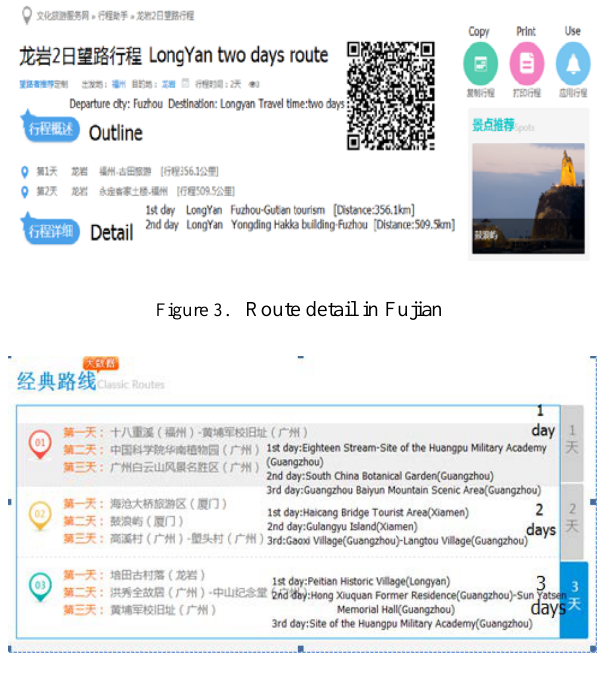
Figure 4. Recommended Routes in Guangdong